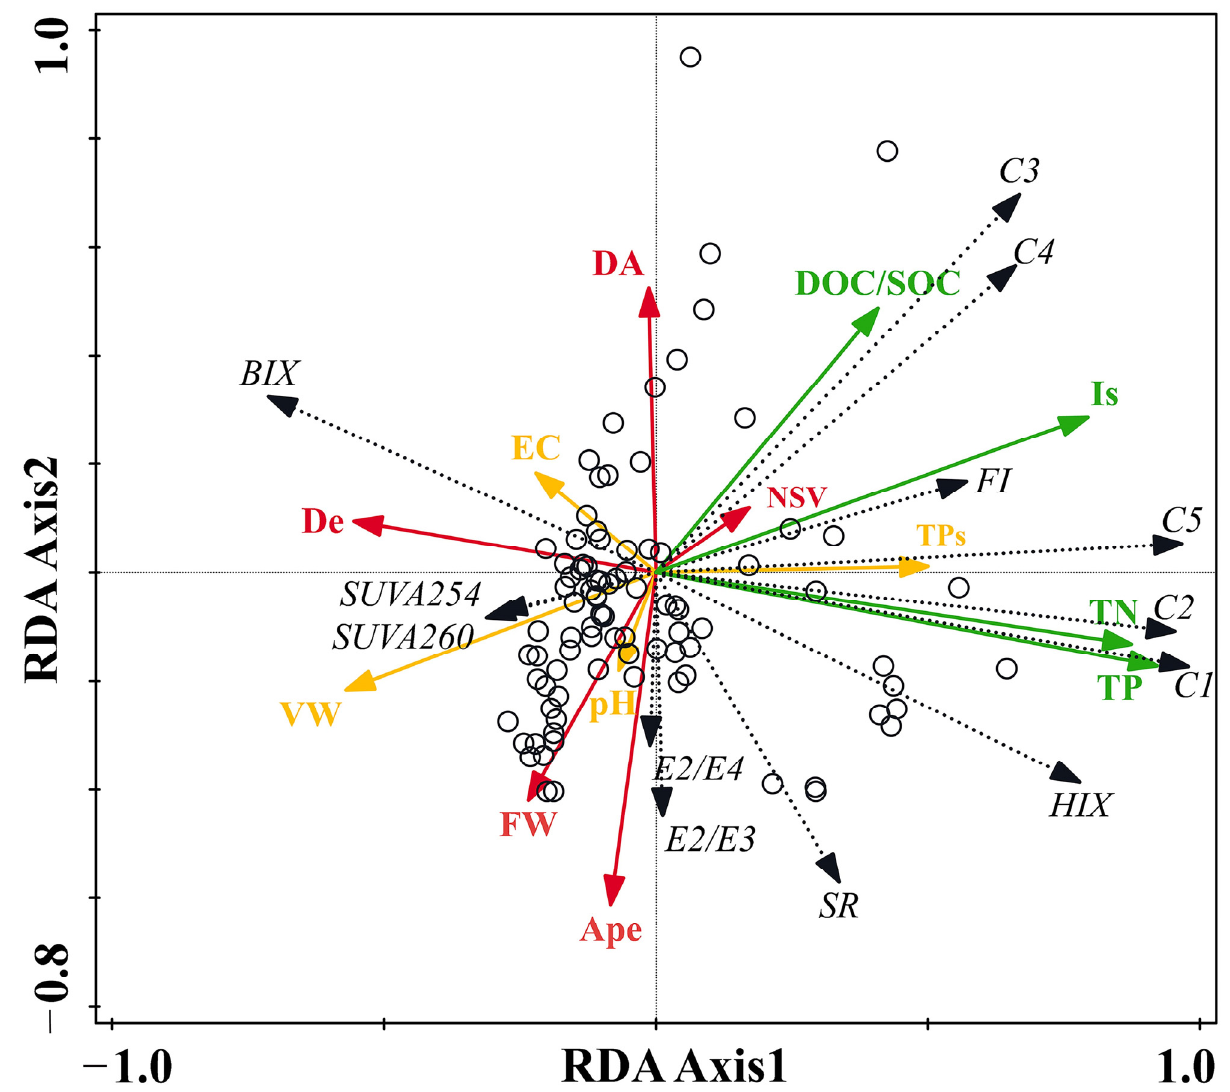
Figure 7. RDA ranking plots of DOM control factors (solid line) and Spectral factor properties (dashed line) in fractured soil. The red, yellow, and green solid lines represent environmental factors (NSV, FW, De, and Ape), soil physical factors (VW, TPs, EC, and pH), and soil chemistry factors (TP, TN, DOC/SOC, and Is), respectively.